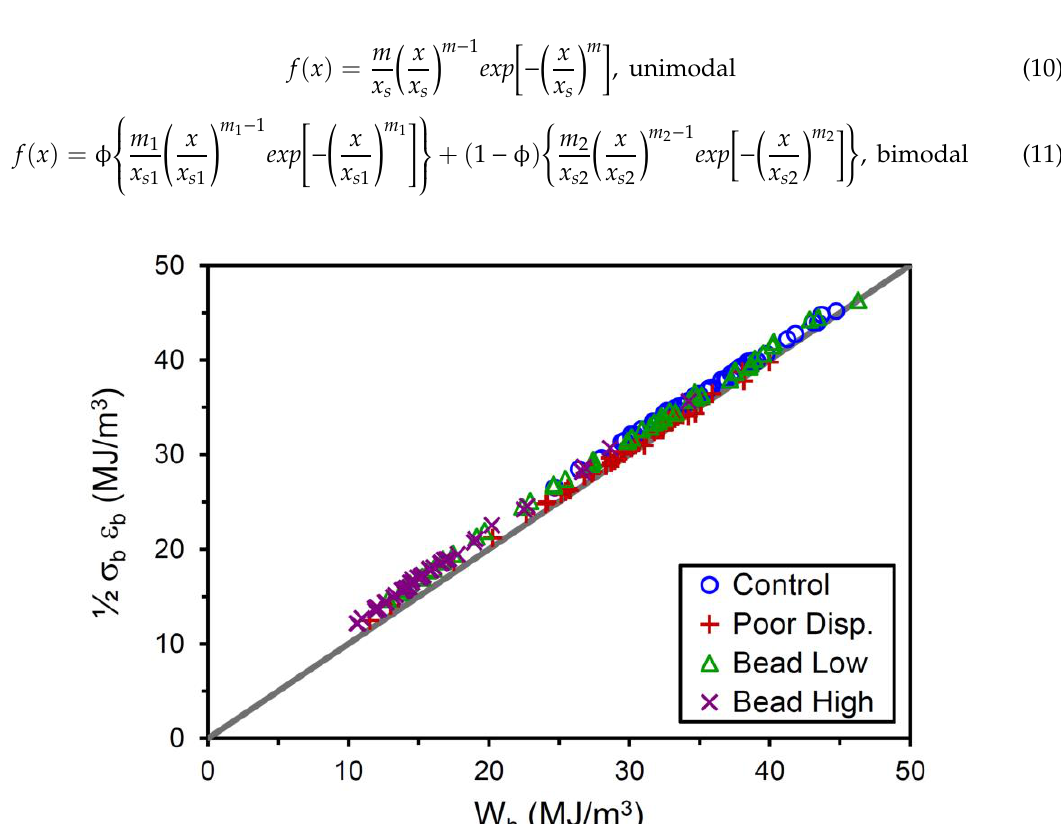
Figure 11. Approximation for strain energy density at break ( W b ≈ 1 ⁄ 2 σ b ε b ) versus actual W b for the four compounds. The solid line shows equivalence of the two quantities.